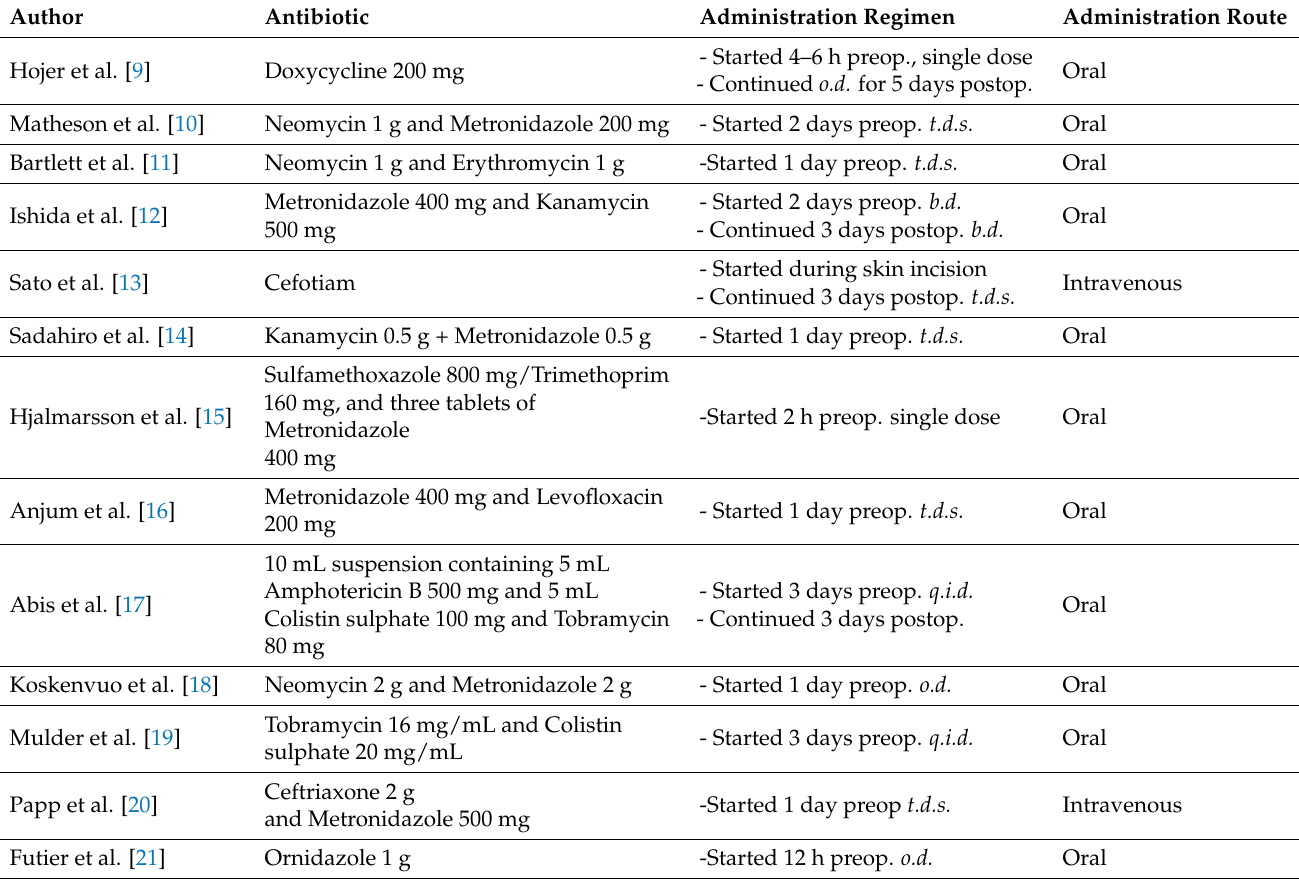
Table 4. Routes of administration and regimens of antibiotic